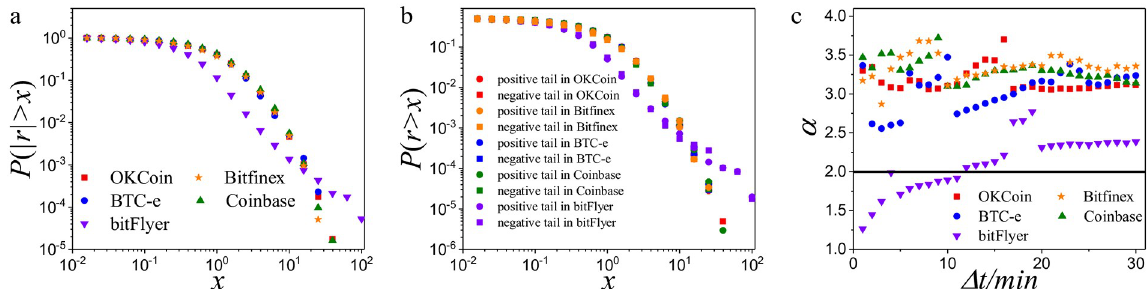
Fig 2. The decay of price return distribution. a , The cumulative distribution of normalized absolute price return in log-log plot. b , The cumulative distribution of normalized price return in log-log plot. c , The power-law exponent α versus Δ t in different Bitcoin platforms.